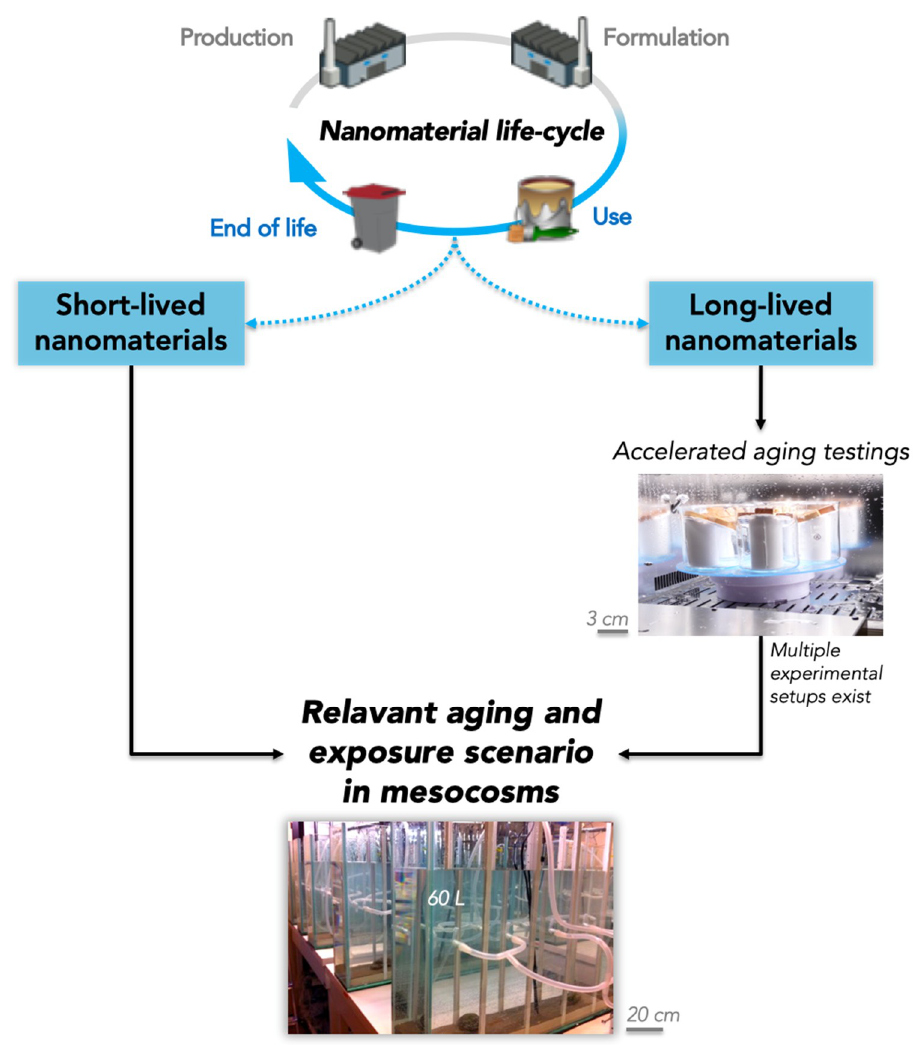
Figure 2. Application type-driven strategy to characterize environmental aging of nanomaterials.